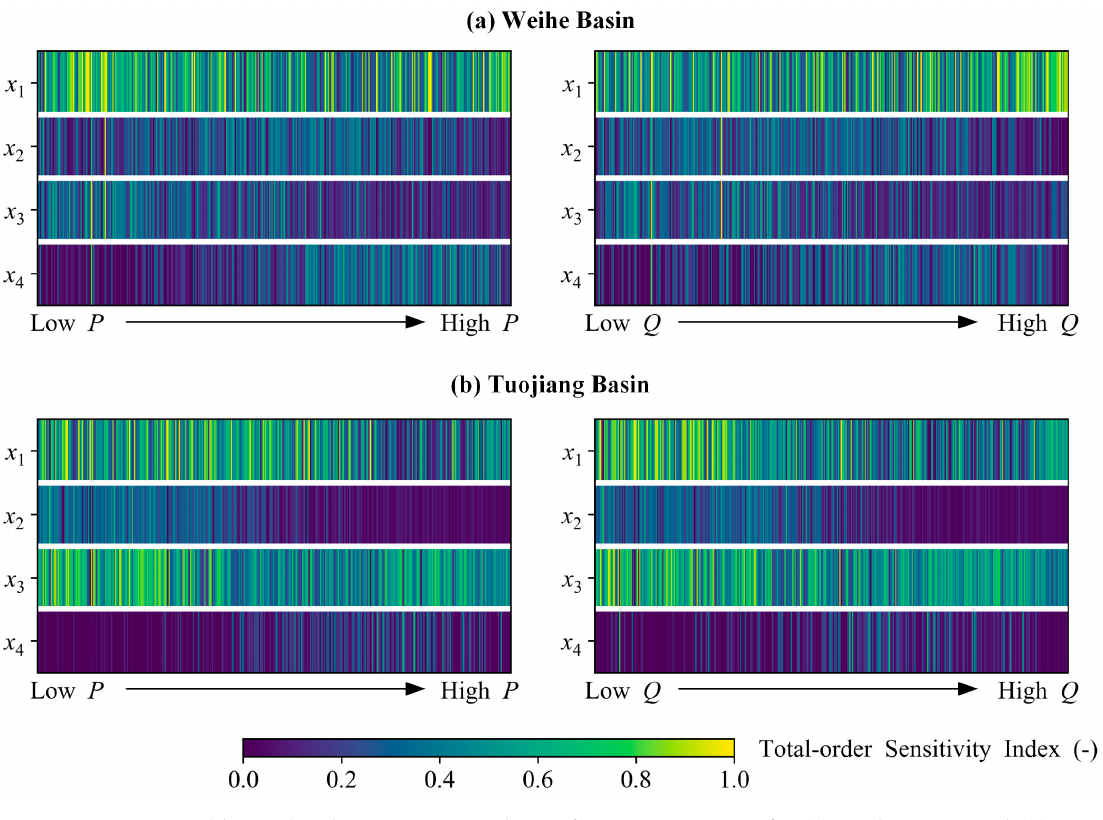
Figure 4. Monthly total-order sensitivity indices of GR4J parameters for ( a ) Weihe Basin and ( b ) Tuojiang Basin. For each basin, the left panel and the right panel share the same sensitivity indices, but they are sorted by monthly total precipitation (left) and monthly streamflow (right), respectively.